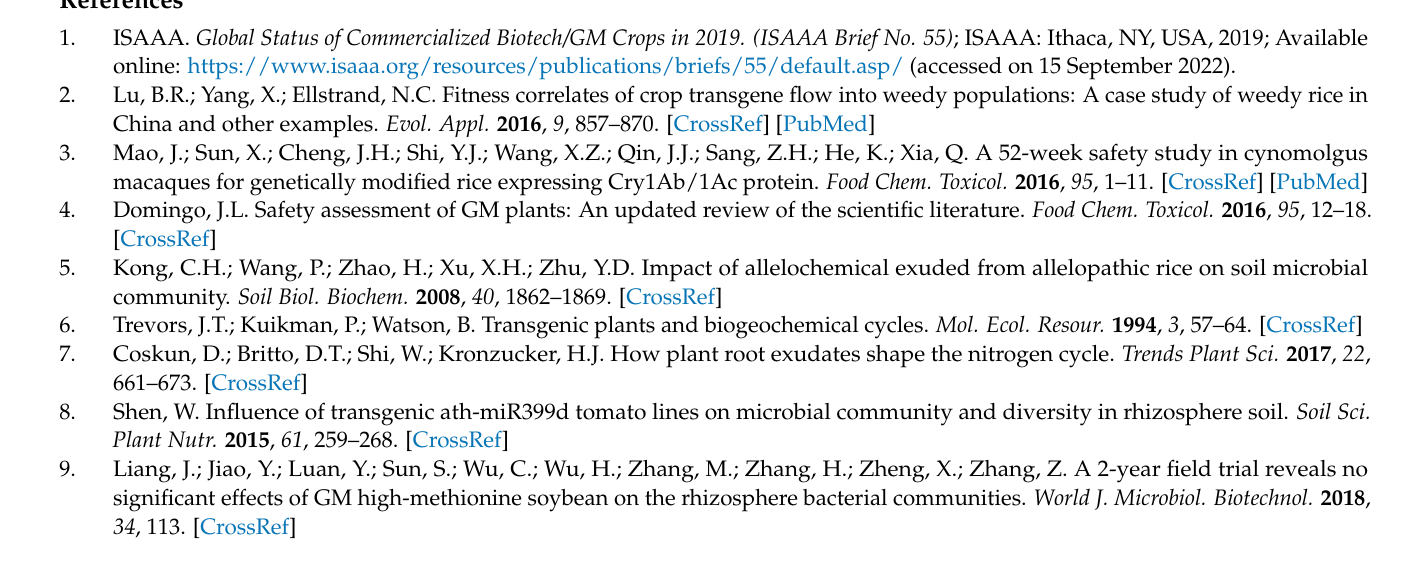
Figure S4: Heat maps of the soil rhizosphere fungal composition at the genus level; Table S1: Data statistics and quality control 16S rDNA amplicon sequencing; Table S2: Data statistics and quality control for ITS amplicon sequencing; Table S3: Comparative analysis of the relative abundance (%) of main bacteria phyla in the rhizosphere of HGK60 and ZD958; Table S4: The relative abundance of main fungi phyla in the rhizosphere soil of HGK60 and ZD958; Table S5: Comparative analysis of the relative abundance of top 4 fungal phyla between HGK60 and ZD958; Table S6: Comparative analysis of the relative abundance of classes belonged to Ascomycota between HGK60 and ZD958; Table S7: Comparative analysis of the relative abundance ( × 10 4 ) of arbuscular mycorrhizal fungi (AMF) between HGK60 and ZD958; Table S8: The Spearman correlation of bacterial alpha diversity and cultivars or growth stages; Table S9: The Spearman correlation of fungal alpha diversity and cultivars or growth stages; Table S10: The primers for PCR